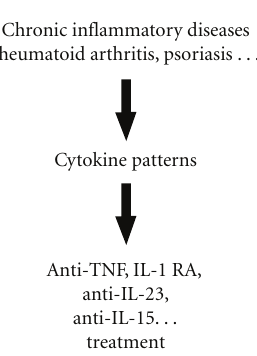
Figure 1: Development of new treatment modalities for chronic inflammatory diseases based on cytokine or chemokine profiles.